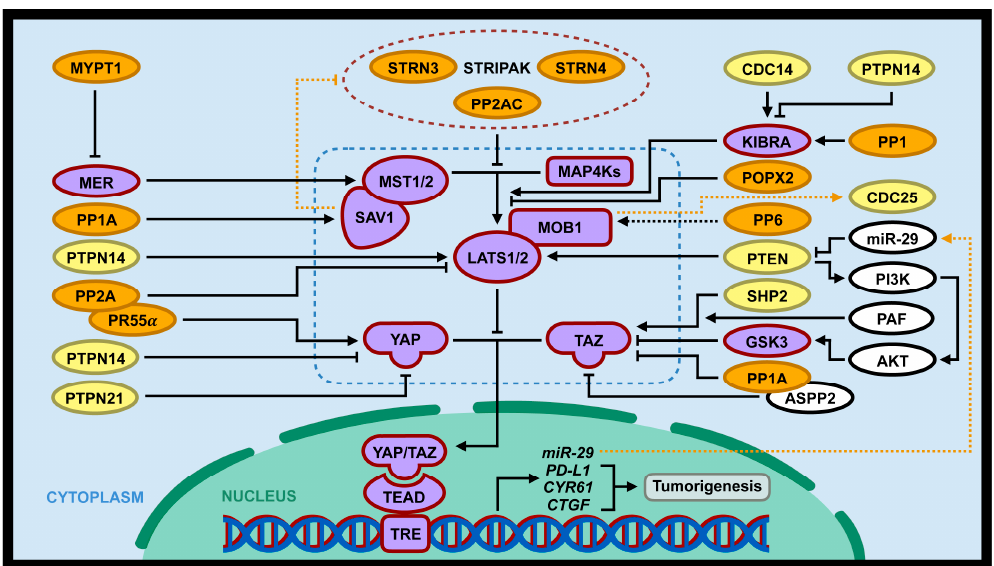
Figure 3. Interaction of the Hippo pathway and phosphatases in tumorigenesis. PSPs (PP2A/PR55 α , PP1, PP1A, POPX2, and MYPT1; gene symbols with orange background) and PTPs (SHP2/PTPN1, PTPN14, PTPN21, CDC14, PTEN; gene symbols with yellow background) can regulate tumorigenesis through positive or negative regulation of the Hippo pathway (gene symbols with purple background). Dotted blue lines includes core components of the Hippo pathway (MST1/2, MAP4Ks, SAV1, MOB1, LATS1/2, and YAP/TAZ). In addition, the Hippo pathway can directly or indirectly regulate several phosphatases (PP2A, CDC25, and PTEN; dotted orange lines).